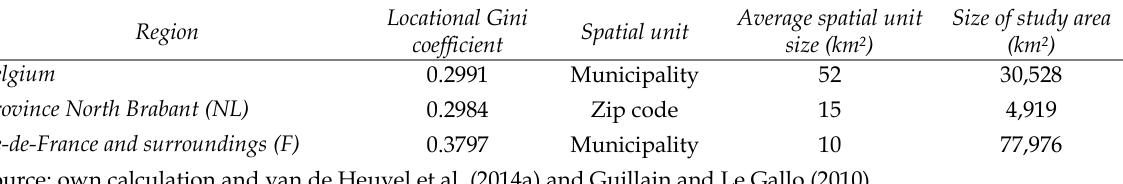
Table 2: Locational Gini